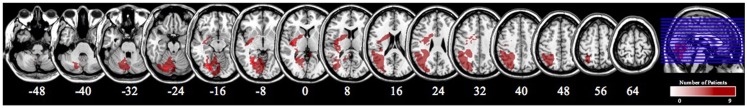
An overlap of the brain lesions of all nine patients in Experiment 2. All lesions were drawn using MRICron Version 6. Lesions were mapped onto MNI space and smoothed to 3 mm using FWHM. The numbers underneath the images denote the z-coordinates of the MNI template.